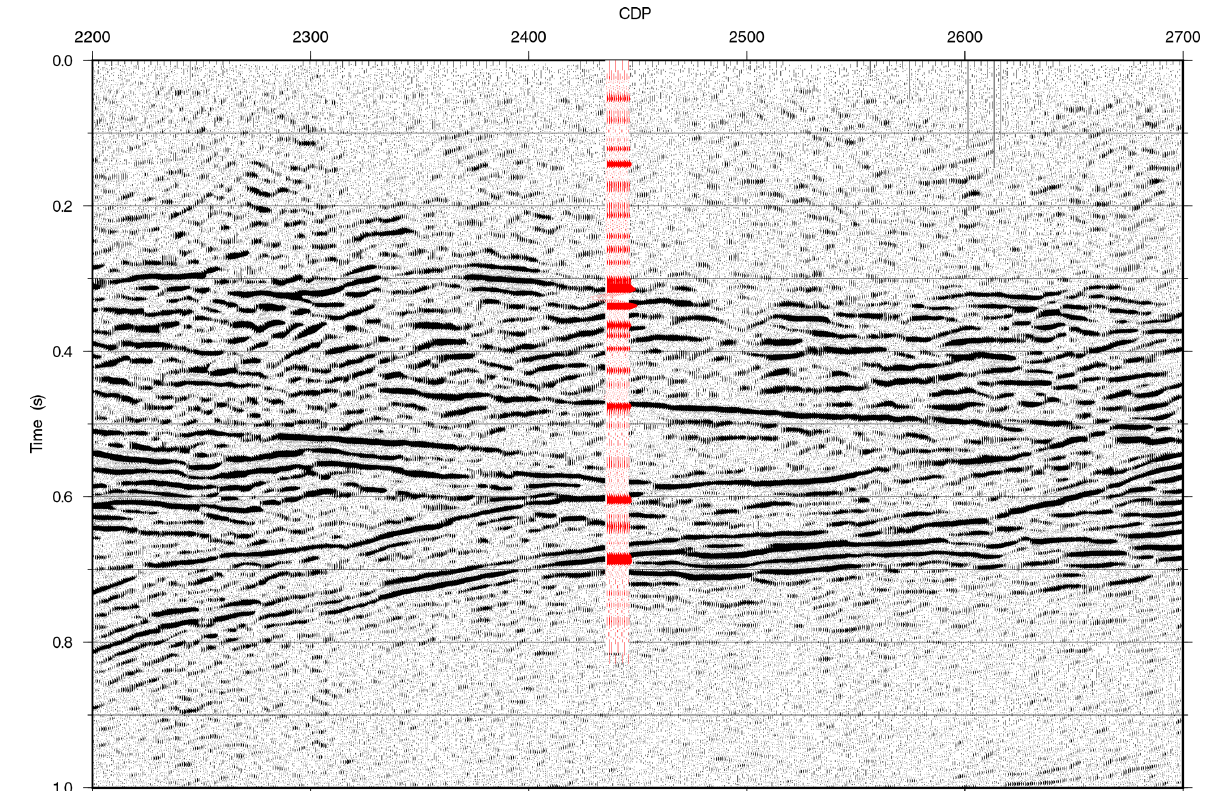
Figure 7. Synthetic seismogram (in red) with the trace repeated 10 times and plotted on top of the time-migrated surface seismic section. The synthetic seismogram was generated using the sonic log shown in Fig. 6 as